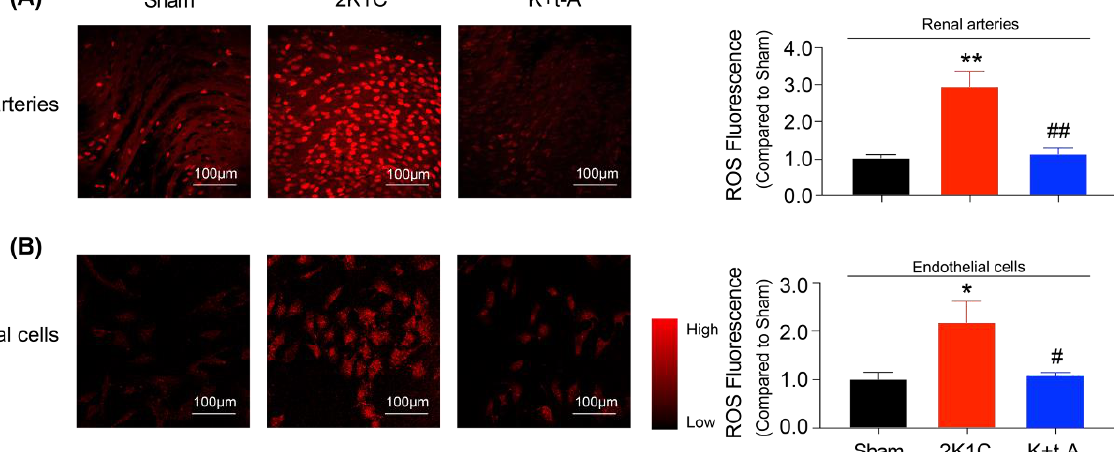
Figure 4. t-AUCB attenuated the oxidative stress in renal endothelial cells from hypertensive rats. Representative images (( A ), left ) of en face preparation for DHE fluorescence in the renal arterial endothelium of Sham, 2K1C, and 2K1C + t-AUCB (K + t-A) rats, along with the quantification of DHE fluorescence (( A ), right ). Representative images (( B ), left ) of ROS in the renal endothelial cells isolated from the three groups and the quantification of fluorescence (( B ), right ). n = 4 per group. Data are presented as mean ± SEM. * p < 0.05, ** p < 0.01 vs. Sham; # p < 0.05, ## p < 0.01 vs. 2K1C.